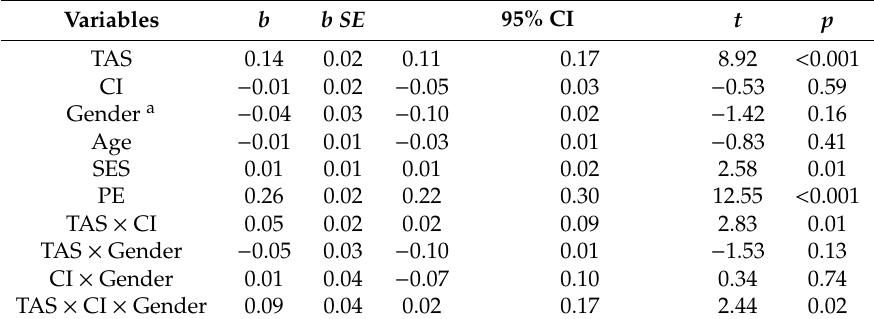
Table 3. Linear regression analysis predicting social competence from teacher autonomy support, consistency, and students’ gender.